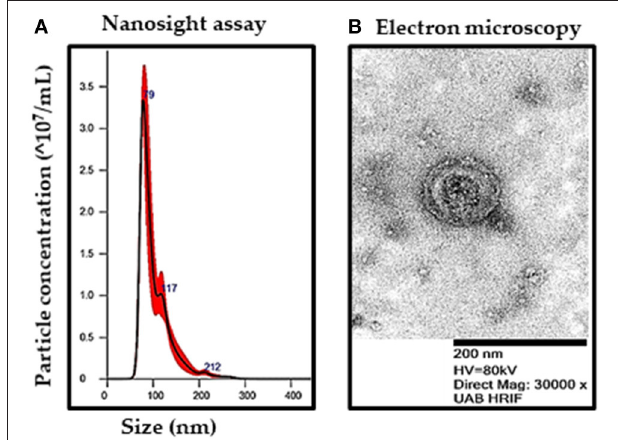
FIGURE 2 | Characterization of exosomes from fibroblast-conditioned media after TGF β treatments. (A) Size and number of exosomes were determined by nanoparticle tracking analysis. (B) Representative image by transmission electron microscopy (magnification 30,000X) revealed the presence of double-membrane bound, cup-shaped